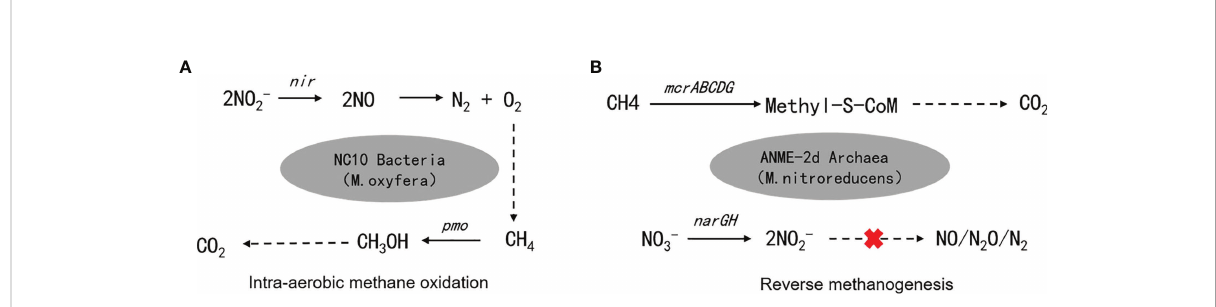
FIGURE 1 Metabolic pathways of (A) nitrite-dependent DAMO mediated by NC10 bacteria M. oxyfera and (B) nitrate-dependent DAMO mediated by ANME-2d archaea M.nitroreducens.